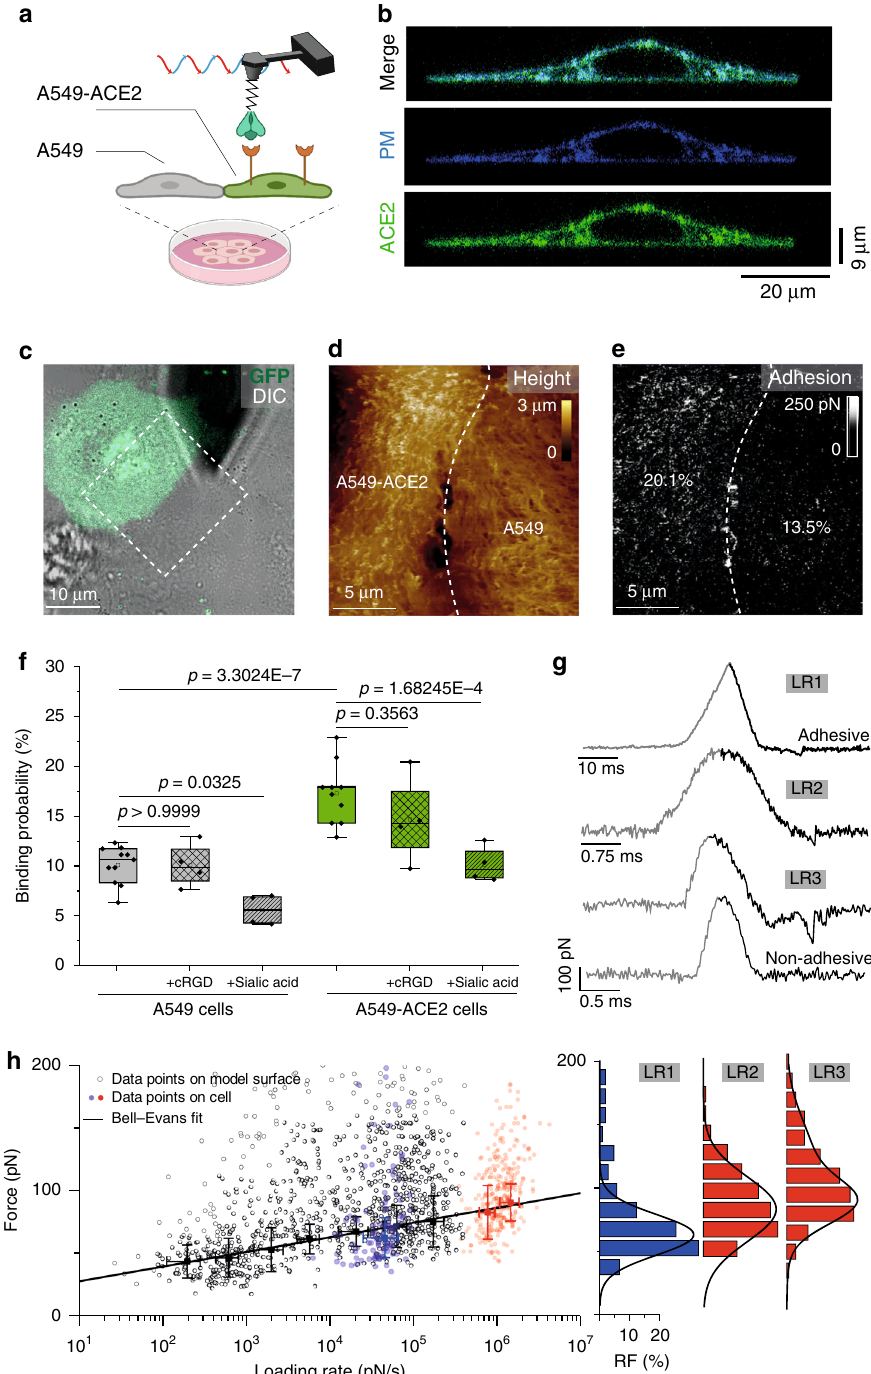
cells (Fig. 3f and Supplementary Fig. 8). For integrins, injection of cRGD only reduces the binding frequency of ~1 – 2% on both cell types, which is in good agreement with the fact that integrins are mostly expressed on the bottom of the cell 26 . Altogether, these data obtained on cells by AFM represent to date the best evidence that S1 – ACE2 complex is established in physiologically relevant conditions and underlines the complex situation with multiple cell-surface receptors accounting for the whole